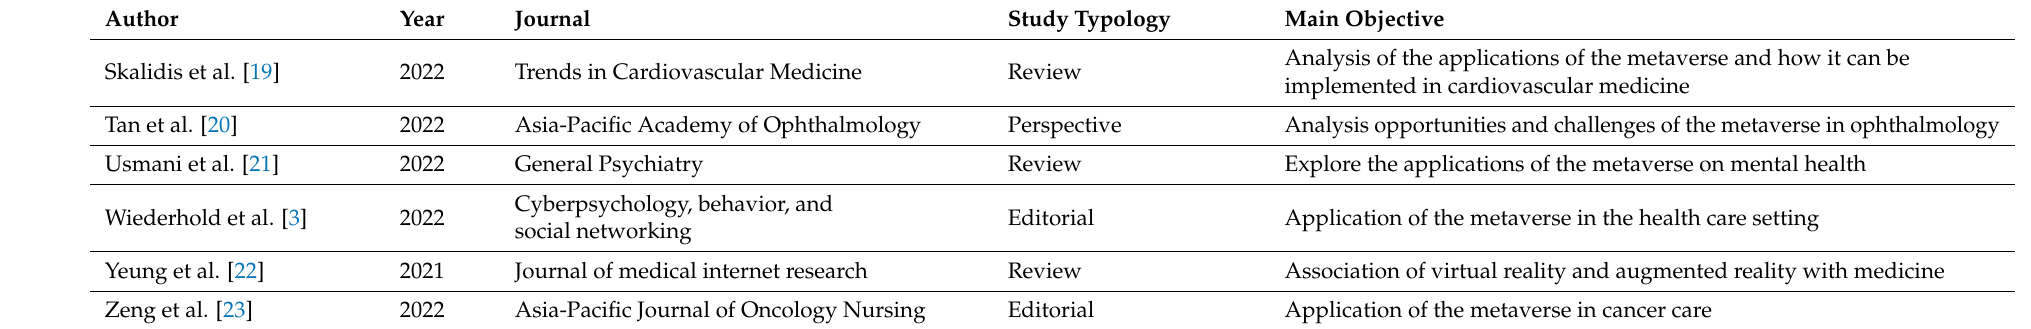
Table 2. Characteristics of the included